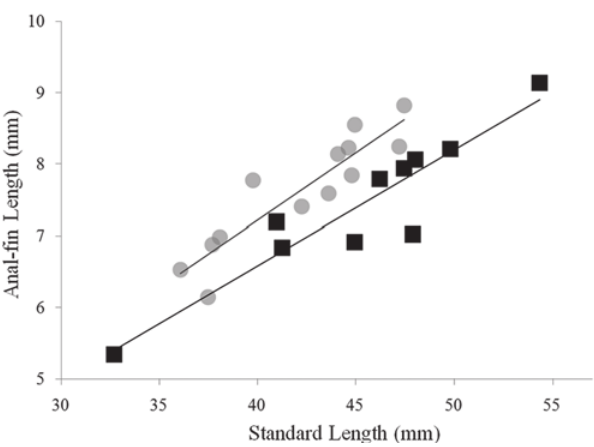
Fig. 4. Moenkhausia rubra , pelvic-fin length as function of standard length by sex and maturity. Gray circles = males (n= 13); black squares = females/ immature specimens (n=